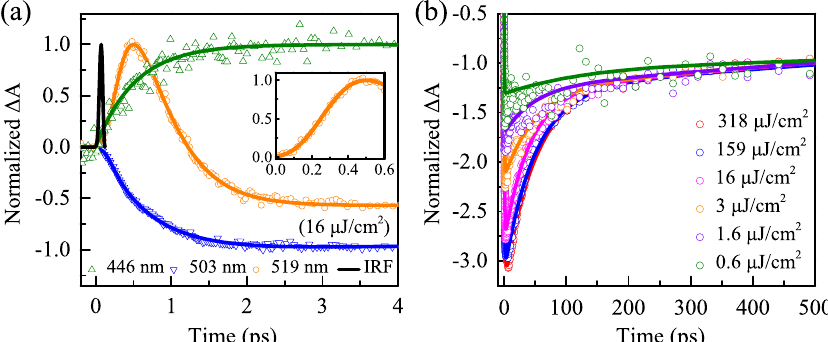
Figure 4. ( a ) TA dynamics detected at the peaks of PA1 (446 nm), PA2 (519 nm), and GSB (503 nm) early scale. Inset: zoomed-in view of the early time for PA2 band. The black-line is IRF. ( b ) Pump fluence dependence of the normalized TA dynamics at the GSB peaks on the long time